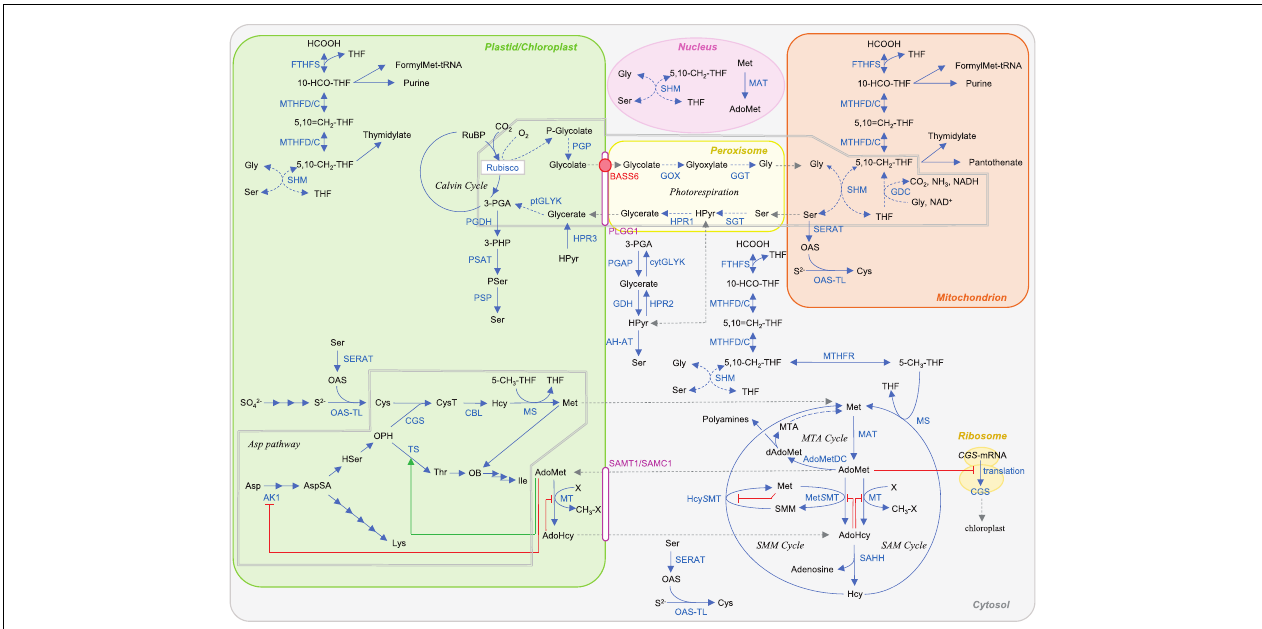
FIGURE 1 | Plant metabolic pathways targeted in this article. Red and green lines indicate repression and activation of the reaction by metabolites. Abbreviations: BASS6, bile acid sodium symporter 6; PLGG1, plastidal glycolate glycerate translocator 1; SAMT1/SAMC1, S -adenosylmethionine transporter 1/ S -adenosylmethionine carrier 1. Other abbreviations are listed in Table 1